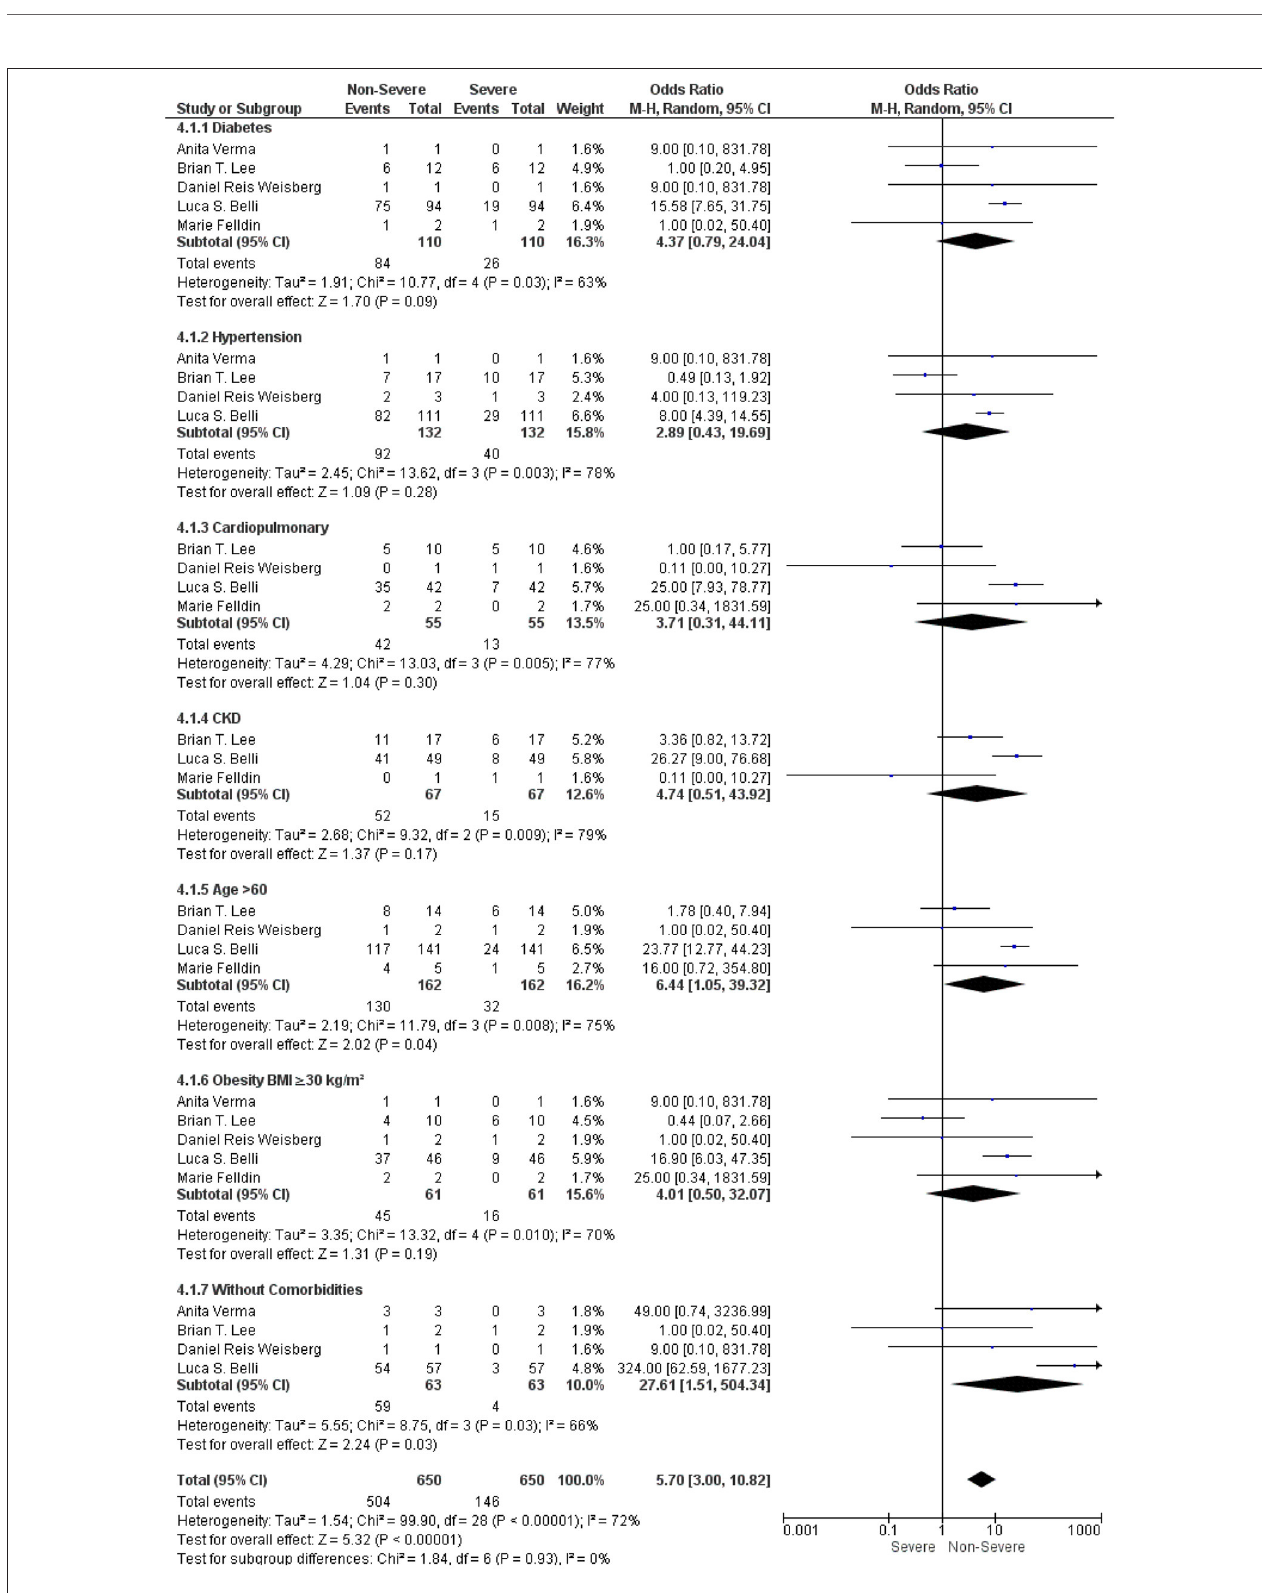
FIGURE 4 | Forest plots for an association between the non-severe and severe LT recipients with COVID-19 based on comorbidities under an immunosuppressive therapy.